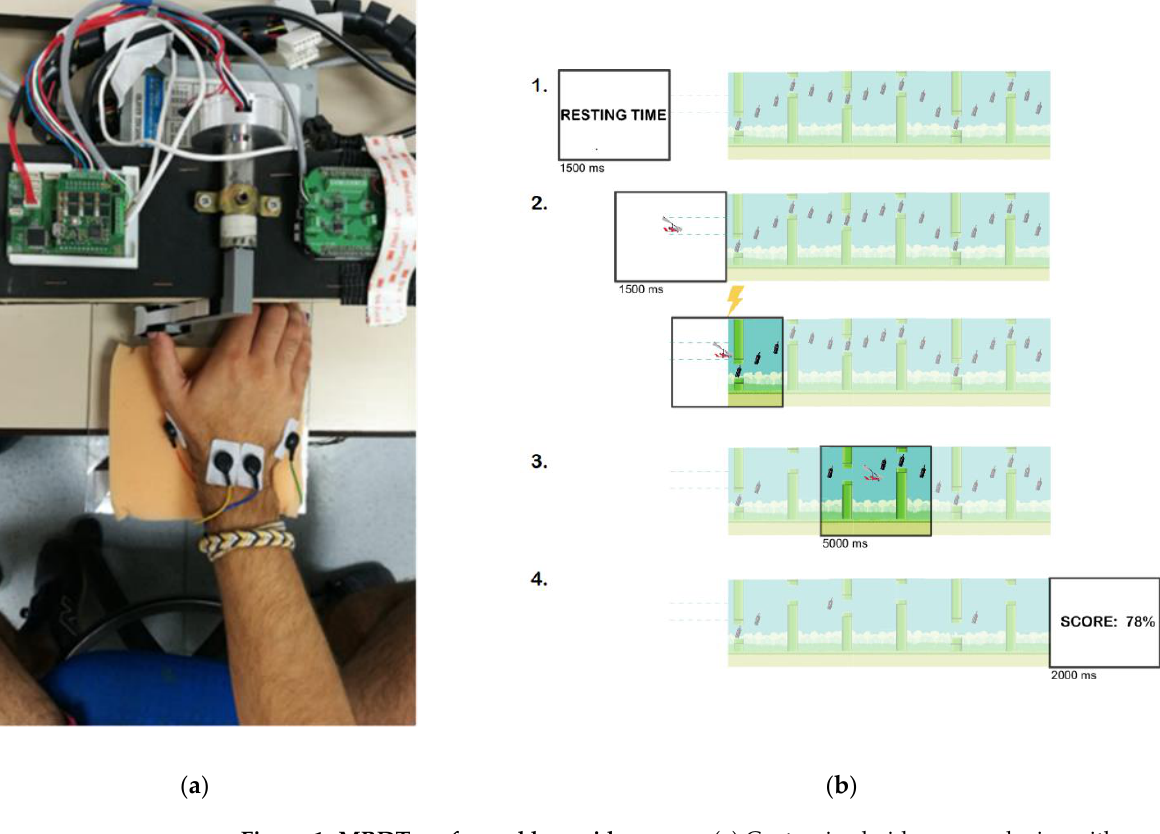
Figure 1. MRDT performed by a video game. ( a ) Customized video game device with a position sensor, electronic board, and BBB board. ( b ) Task phases of MRDT: 1. Resting phase; 2. pre- movement phase; 3. movement phase; 4. feedback phase. TMS application time is indicated by the lightning signal.